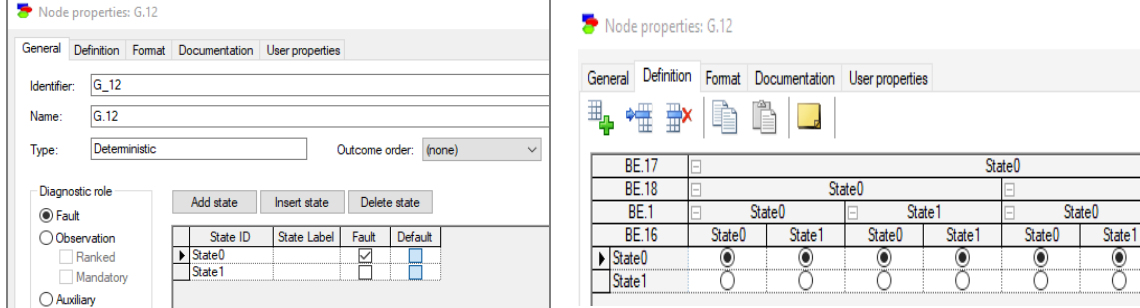
Figure 7. Bayesian network of the FFTA model in Figure 3. Energies 2021 , 14 , x FOR PEER REVIEW 17 of 21